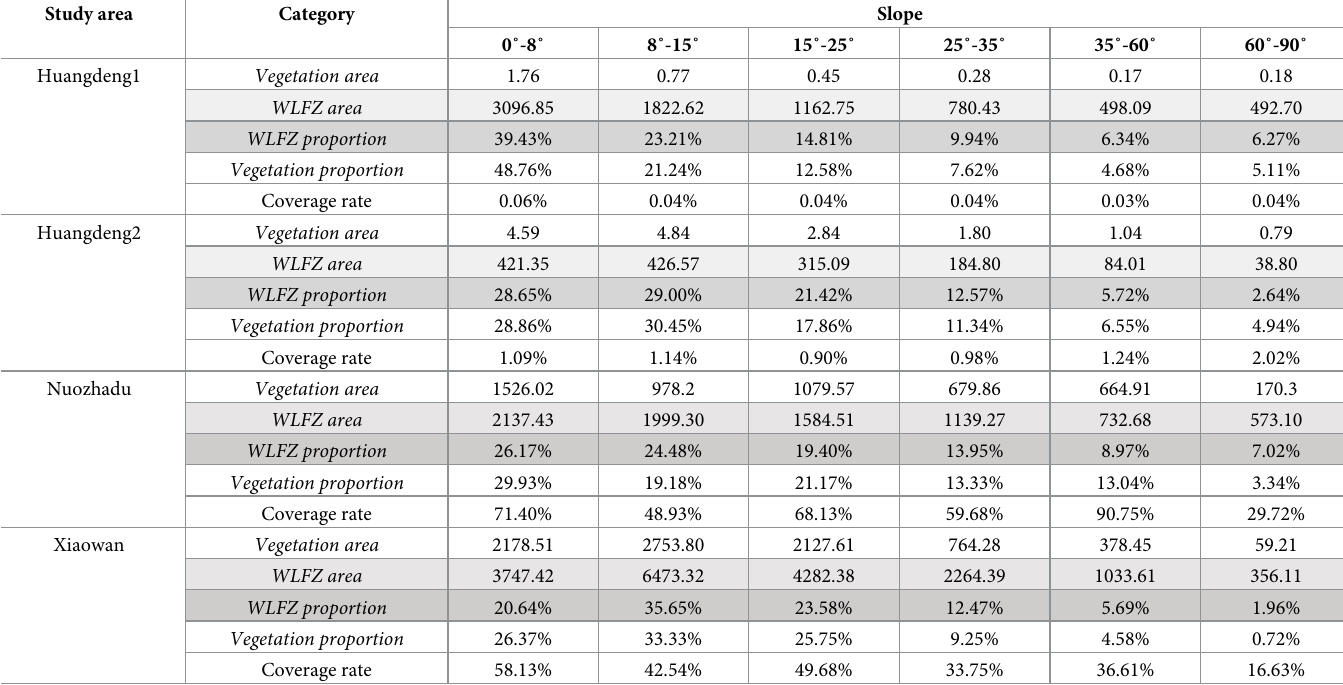
Table 3. The area, proportion and vegetation area, proportion and coverage of the WLFZ classified by slope in each study area in 2019. Study area